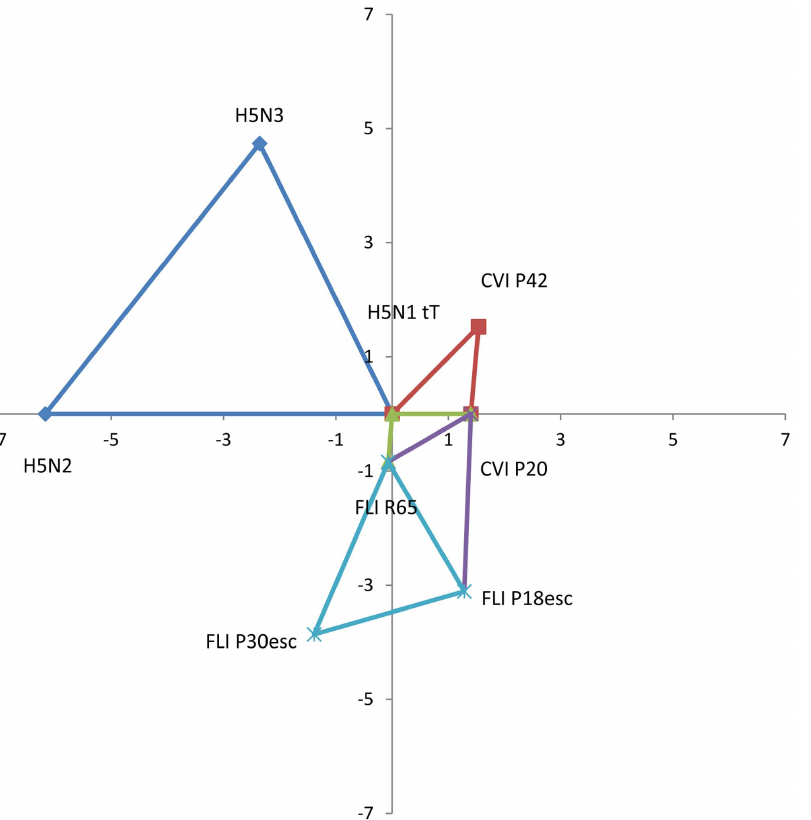
Figure 2. Antigenic map of sets of strains used in this study. Antigenic map showing the standardized real distances between different sets of three strains. Distances are in log 2 values. Antigenic distance between H5N1 t/T and CVI P20 or CVI P42 is 1.4 and 2.17 respectively. Distance between H5N1 R65 and FLI P18esc or FLI P30esc is 2.64 and 3.3 respectively. Both parent strains (H5N1 t/T and H5N1 R65) are antigenically similar (distance of 0.84). Both parent strains are very antigenically distant to the H5N2 and H5N3 strains used in the study. In detail, the distance between H5N1 t/T and H5N2 or H5N3 is 6.17 and 5.29 respectively, while the distance between H5N1 R65 and H5N2 or H5N3 is 6.34 and 5.42 respectively (all distances can be found in Table S2 in File